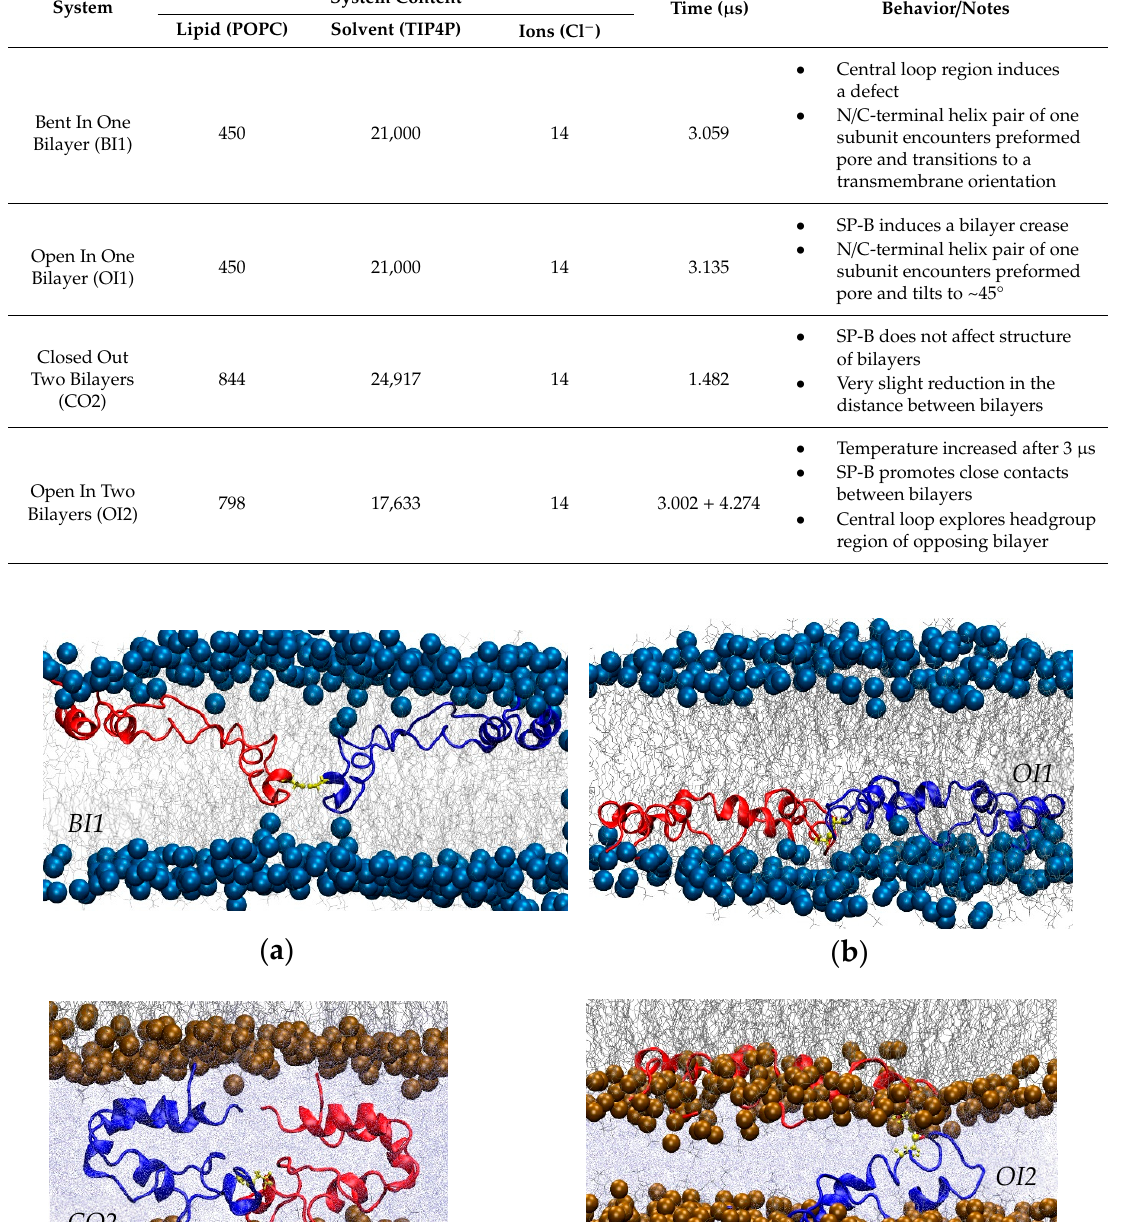
Table 1. Brief summary of simulations. POPC: 1-palmitoyl-2-oleoyl-sn-glycero-3-phosphocholine. TIP4P: transferable intermolecular potential with 4 points.